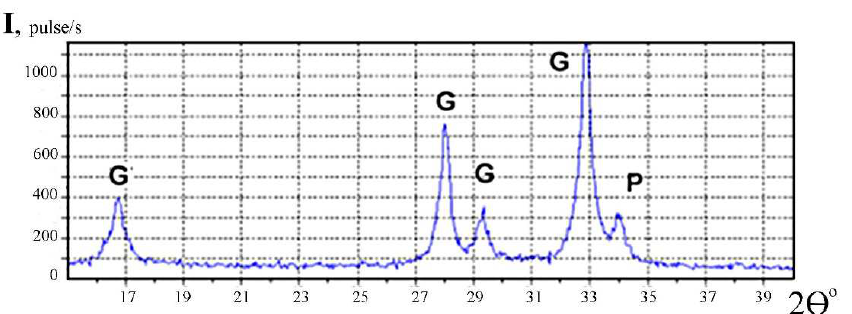
Figure 6. XRD pattern of aerosol powders of YAG, made of a working solution with additive of urea portion. Phase marking: G–YAG Y 3 Al 5 O 12 ; P–YAP YAlO 3. The peaks corresponding to the YAG phase can be seen to have become more